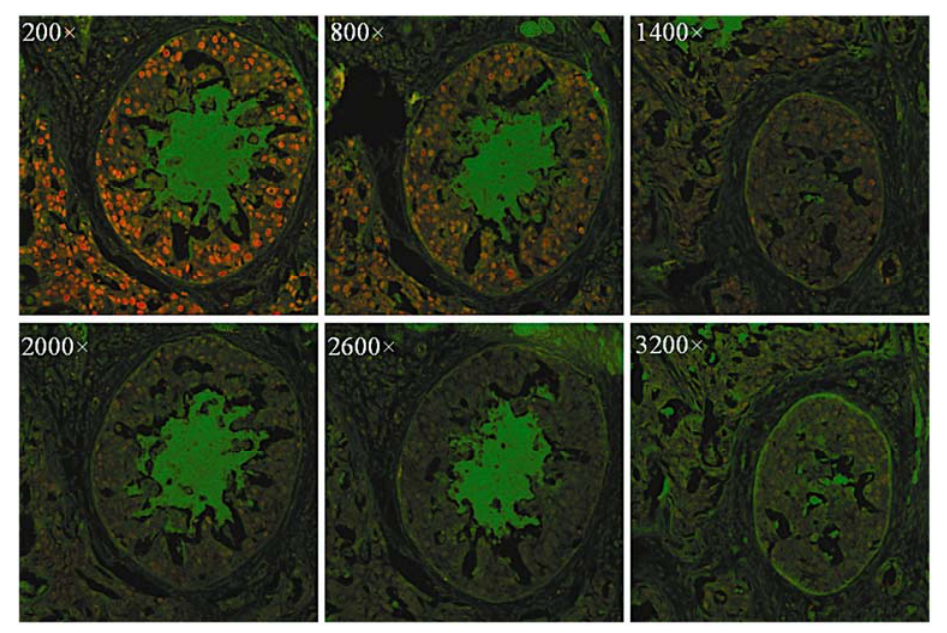
Figure 5. Fluorescence images of breast cancer tissues labeled with CdSe/ZnS QDs. PCNA was stained red with QDs modified with the antibody. The original QD-SA concentration was about 1 μ mol/L and was diluted 200–3200× before staining operations. Reprinted with permission from [40]. Copyright 2010 Society for Applied